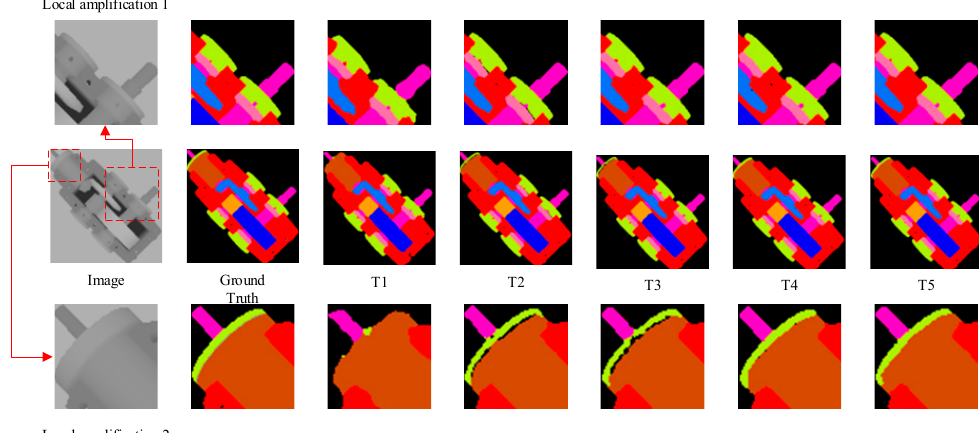
Figure 7. The effect images and local amplified images in each experiment.